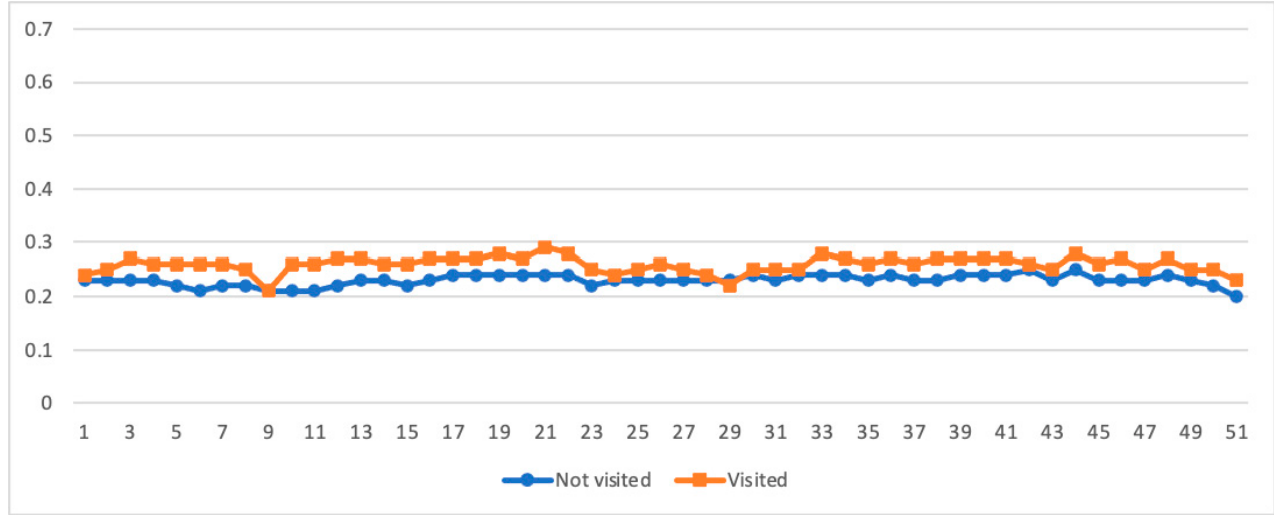
Figure 4. Weekly mean number of posts/comments per participant made in the r/Teenagers subreddit by youth who visited and never visited the mental health subreddits.